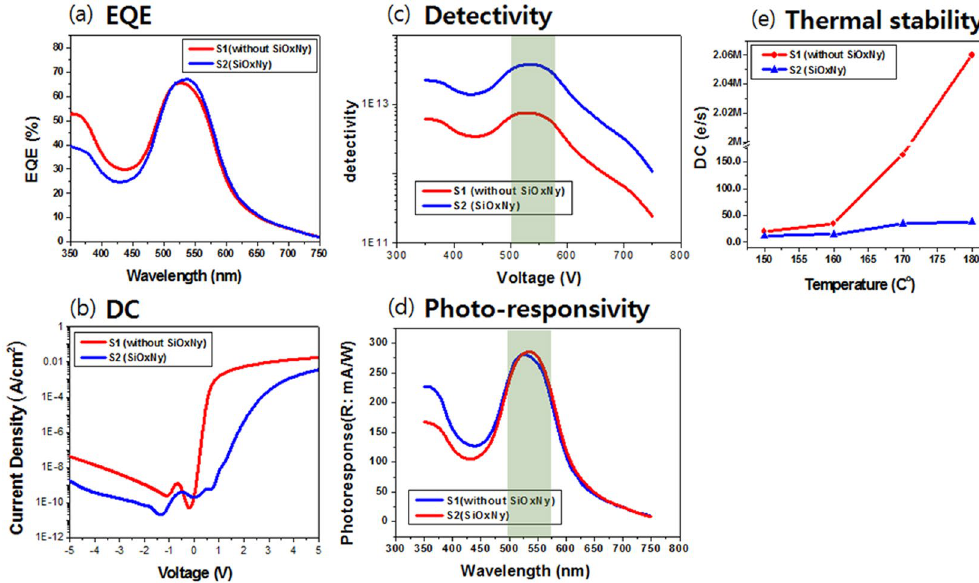
Figure 4. ( a ) EQE curves of S1 (without SiO x N y ) and S2 (i.e with SiO x N y film) measured for the OPDs, respectively. ( b ) Current density-voltage characteristics in the dark for the OPDs in ( a ). ( c ) Detectivities of S1 and S2. ( d ) Photo-responsivities of S1 and S2. ( e ) Thermal stability for DC with a various temperature from 150 °C to 180